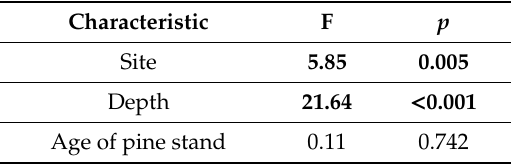
Table 2. Results of three-way analysis of variance for soil moisture content. Note: F test, p —significance level; statistically significant values are marked in